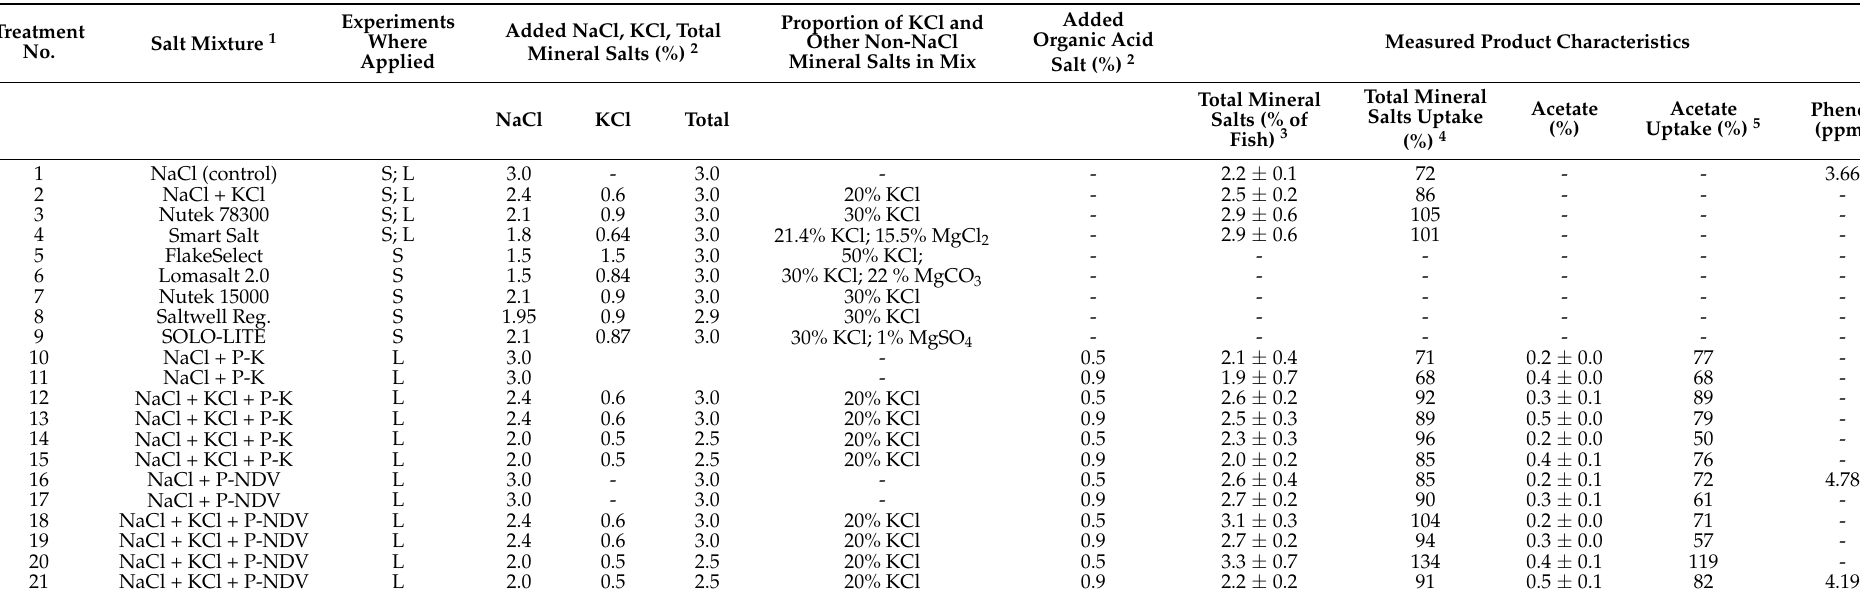
Table 1. Characteristics of produced CS-salmon applied in the sensory screening (S) and/or L. monocytogenes challenge tests (L). Treatment